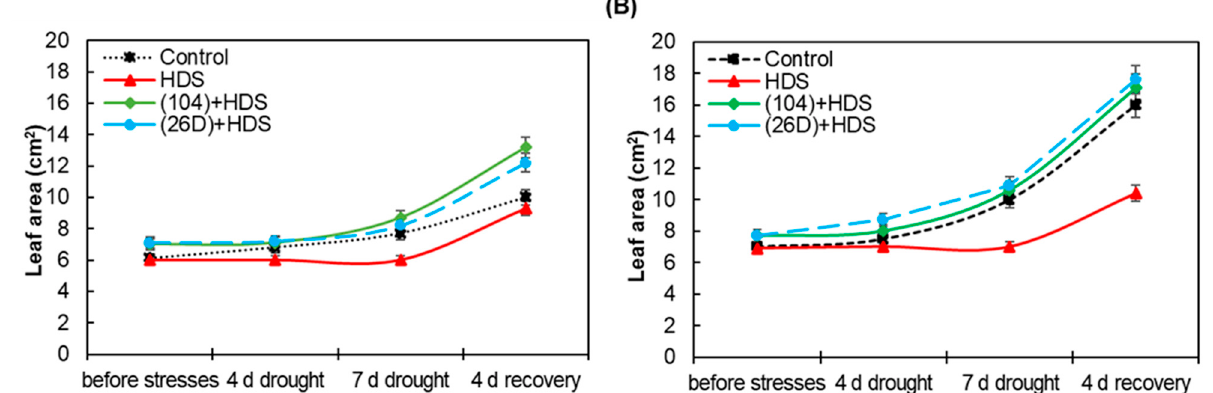
Figure 6. Influence of B. subtilis 104 and 26D on leaf photosynthetic pigments chlorophyll (Chl) a, Chl b ( A ) and leaf area ( B ) of wheat varieties E70 and SY under combined herbicide + drought stress (HDS), as well as in the post-stress period (4 days recovery after the resumption of normal watering). Error bars represent standard errors ( ± SE) of the means in triplicate. Growth parameters were measured using 25 plants from each replicate. Various letters show a significant difference between the averages of different groups at p < 0.05. HDS—herbicide + drought stress.